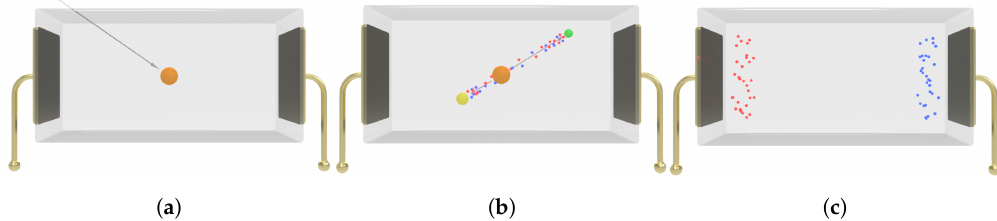
Figure 1. Neutron detection in lithium indium diselenide (LISe) semiconducting sensor. ( a ) incident neutron is absorbed by 6 Li in semiconductor bulk; ( b ) emitted 3 H and α generate charged particle pairs; ( c ) charge carriers driven to electrodes by applied internal electric